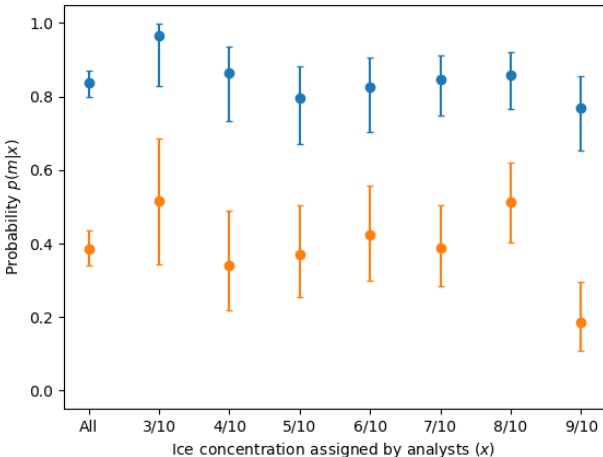
Figure 20. The user’s accuracy, or probability p(m | x) that a poly- gon with an assigned ice concentration will be the assigned ice concentration as calculated by MAGIC (in orange) or ± 1 ice con- centration category (in blue). For example, the orange values show the probability that a polygon assigned 6/10 will be 6/10 accord- ing to MAGIC: p(m = 6 | x = 6 ) . Similarly, this figure reports the probability in blue that a polygon assigned 8/10 will be 7/10, 8/10, or 9/10 according to MAGIC: p(m = 7 , 8 , 9 | x = 8 ) . Only validated polygons were used to estimate these probabilities. The confidence interval was calculated using the Wilson method for binomial prob- ability confidence intervals and shows that the true probability is found within this range at the 95% confidence level. Low ice con- centrations (e.g. 0, 1, and 2/10) and high ice concentrations (9 + and 10/10) were omitted due to lack of sufficient sample